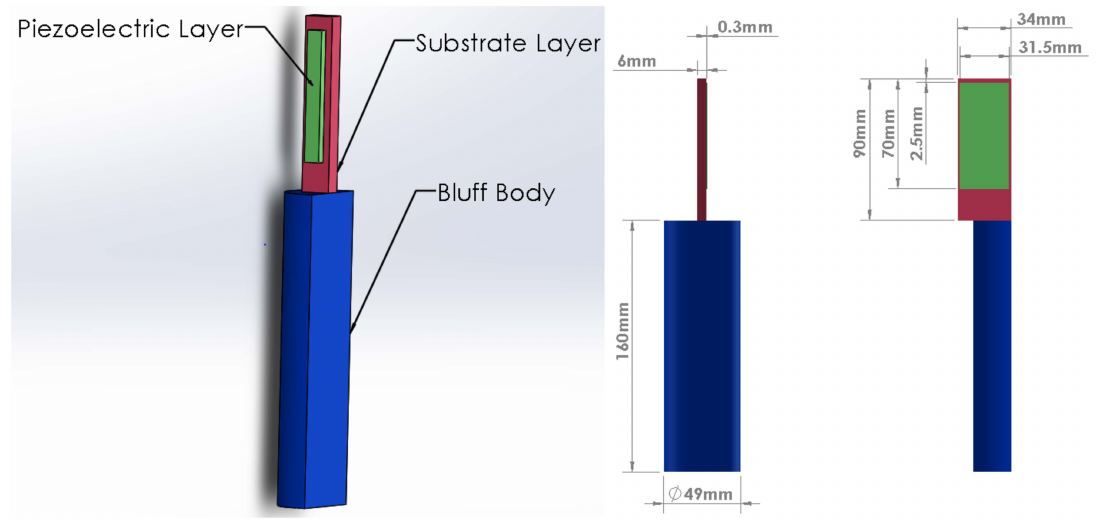
Figure 14. 3D Model and Dimensioned Drawing of Optimal Model.